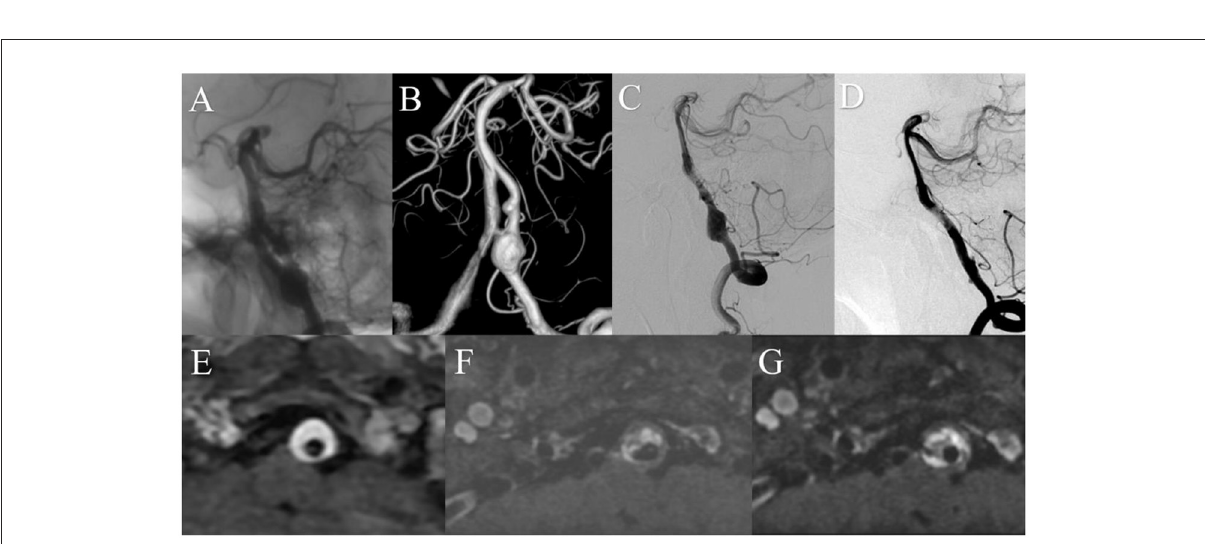
FIGURE4 Preoperative anteroposterior (A) and three-dimensional reconstruction (B) digital subtraction angiography (DSA) showed a left vertebral artery aneurysm. (C) DSA immediately after treatment showed that contrast stasis within the aneurysm. (D) One year after treatment, DSA showed satisfactory arterial reconstruction and complete aneurysm obliteration. Magnetic resonance imaging demonstrated stability of the intramural hematoma over time [ (E) before treatment; (F) 1 year after; (G) 3 years